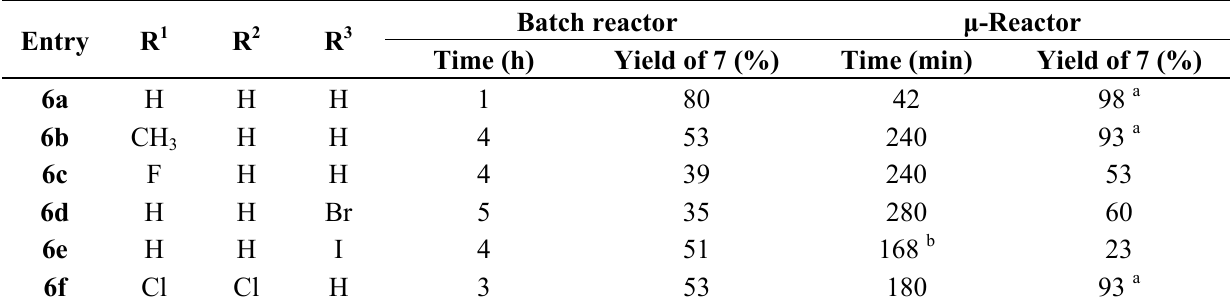
Table 2. Comparison of microreactor versus batch reactor performances.